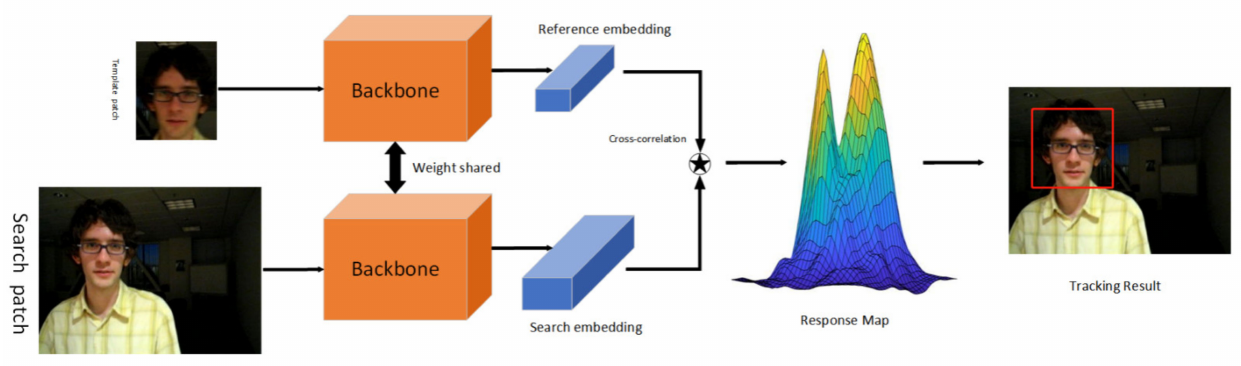
Figure 1. The overall architecture of our proposed single object visual tracking algorithm.